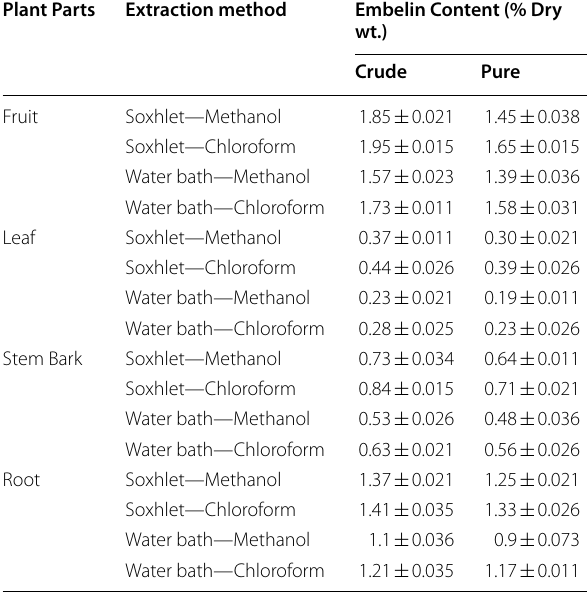
NB-Data are expressed as mean